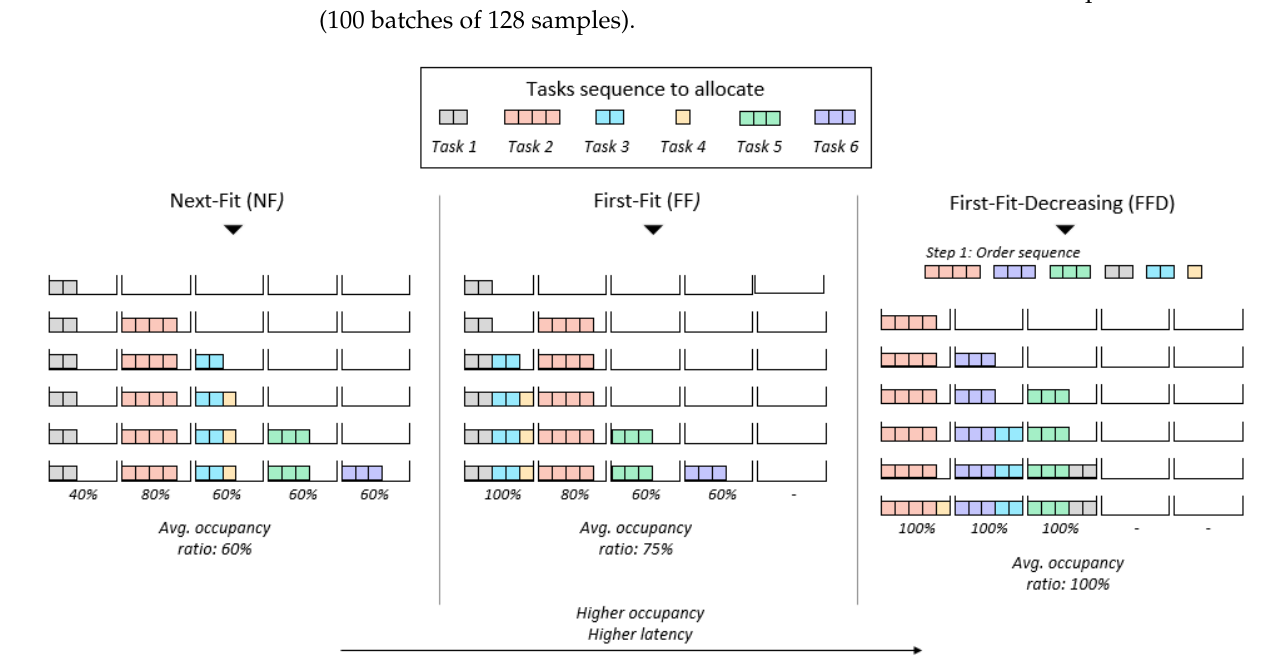
Figure 9. Benchmark heuristics. Visual example of how a given sequence of tasks would be allocated following each of the three benchmark